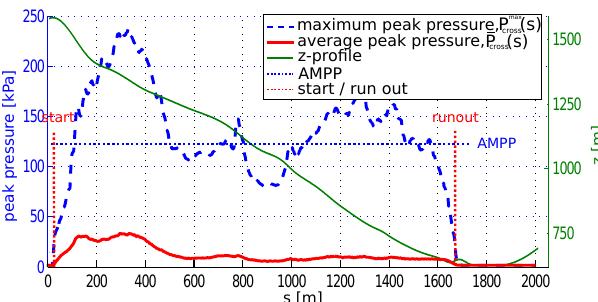
Fig. 4. Cross-sectional maximum P max cross (s) (blue, compare Eq. (14)) and average ¯ P cross (s) (red, compare Eq. (13)) peak pressure along the avalanche path coordinate s . Additionally the averaged maxi- mum peak pressure AMPP (Eq. (15)) and the pressure-based run out is shown. The profile of the central flow line z(s, 0 ) is shown for orientation on the right ordinate. The pressure values t belong the reference simulation run with a release volume of 55 × 10 3 m 3